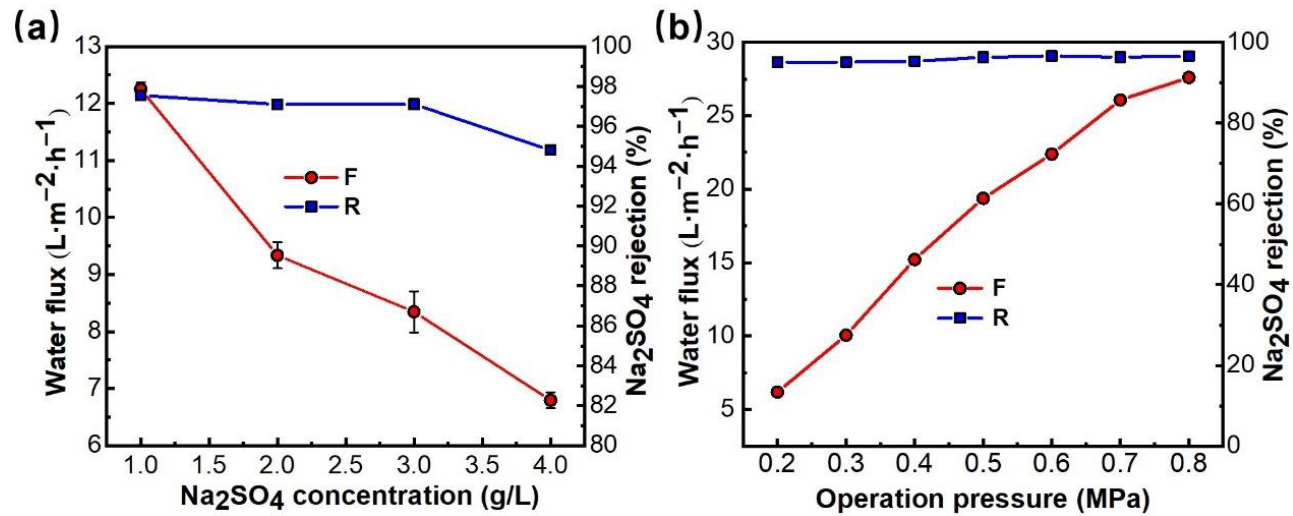
Figure 8. Effects of Na 2 SO 4 concentration ( a ) and operation pressure ( b ) on the permeability of